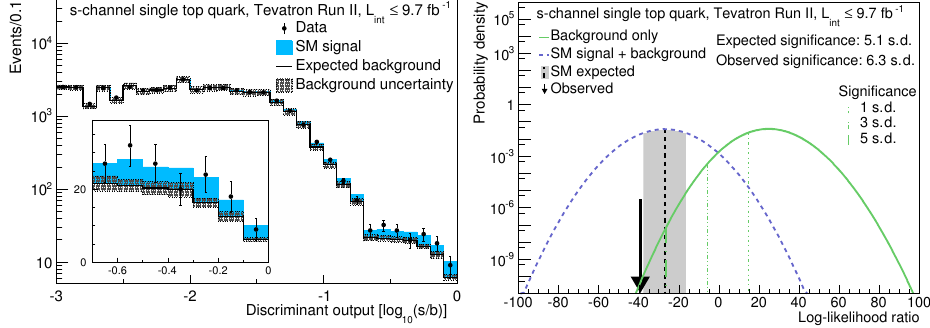
Figure 3. S-channel single top quark observation at the Tevatron. The discriminant (left) and log-likelihood ratio (right) are shown. The inset plot in the left window shows the highest s / b bins, which are the most sensitive to the s-channel single top